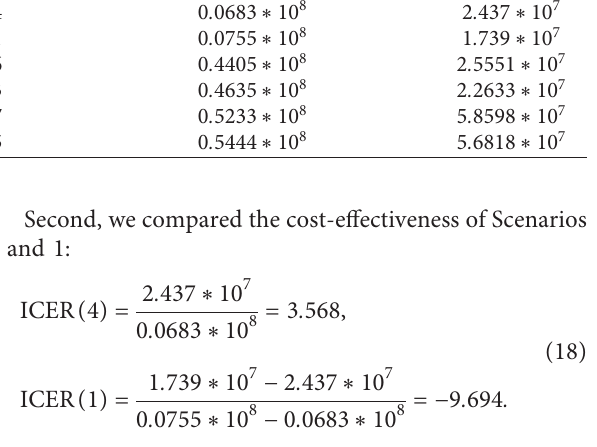
v k . (c) The optimal control